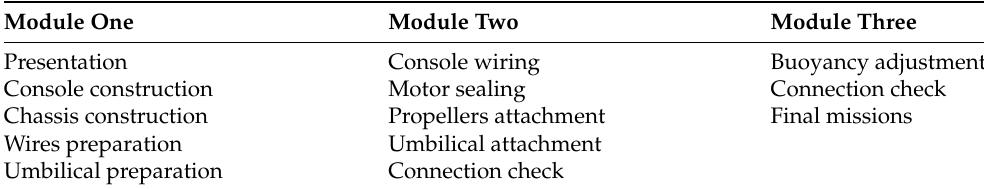
Table 2. Standard three-day format modules.